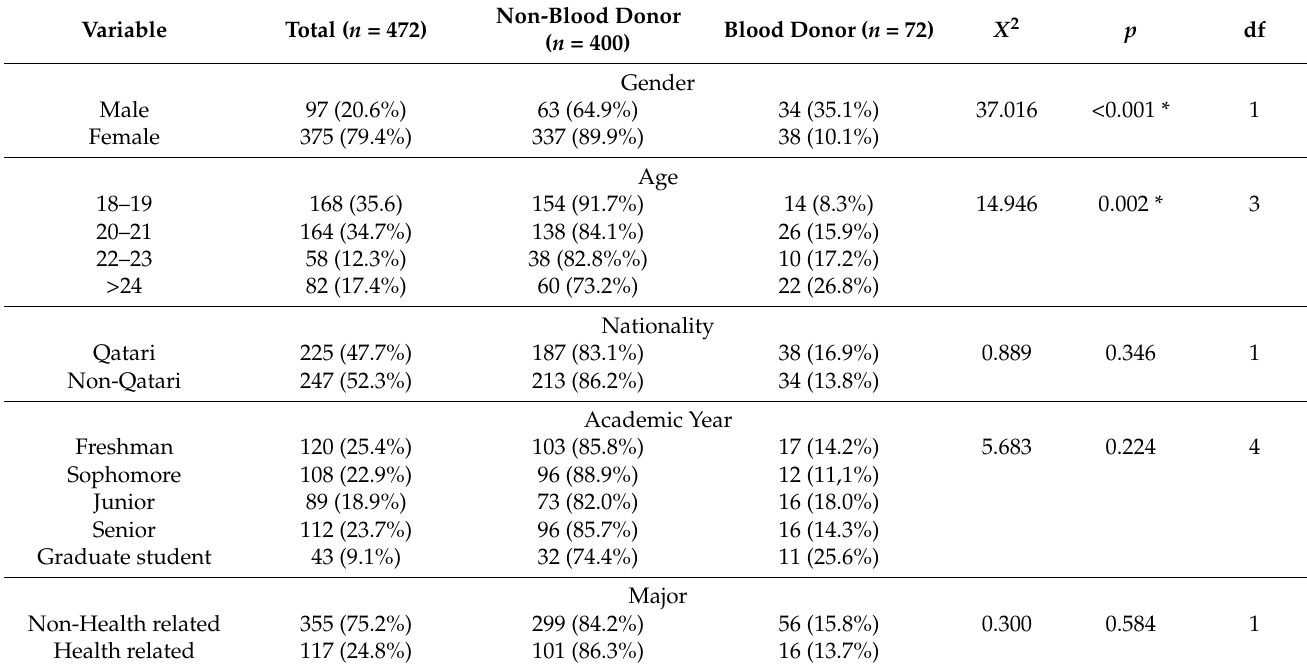
Table 1. Univariate association between sociodemographic characteristics donor status of respondents ( N = 472).